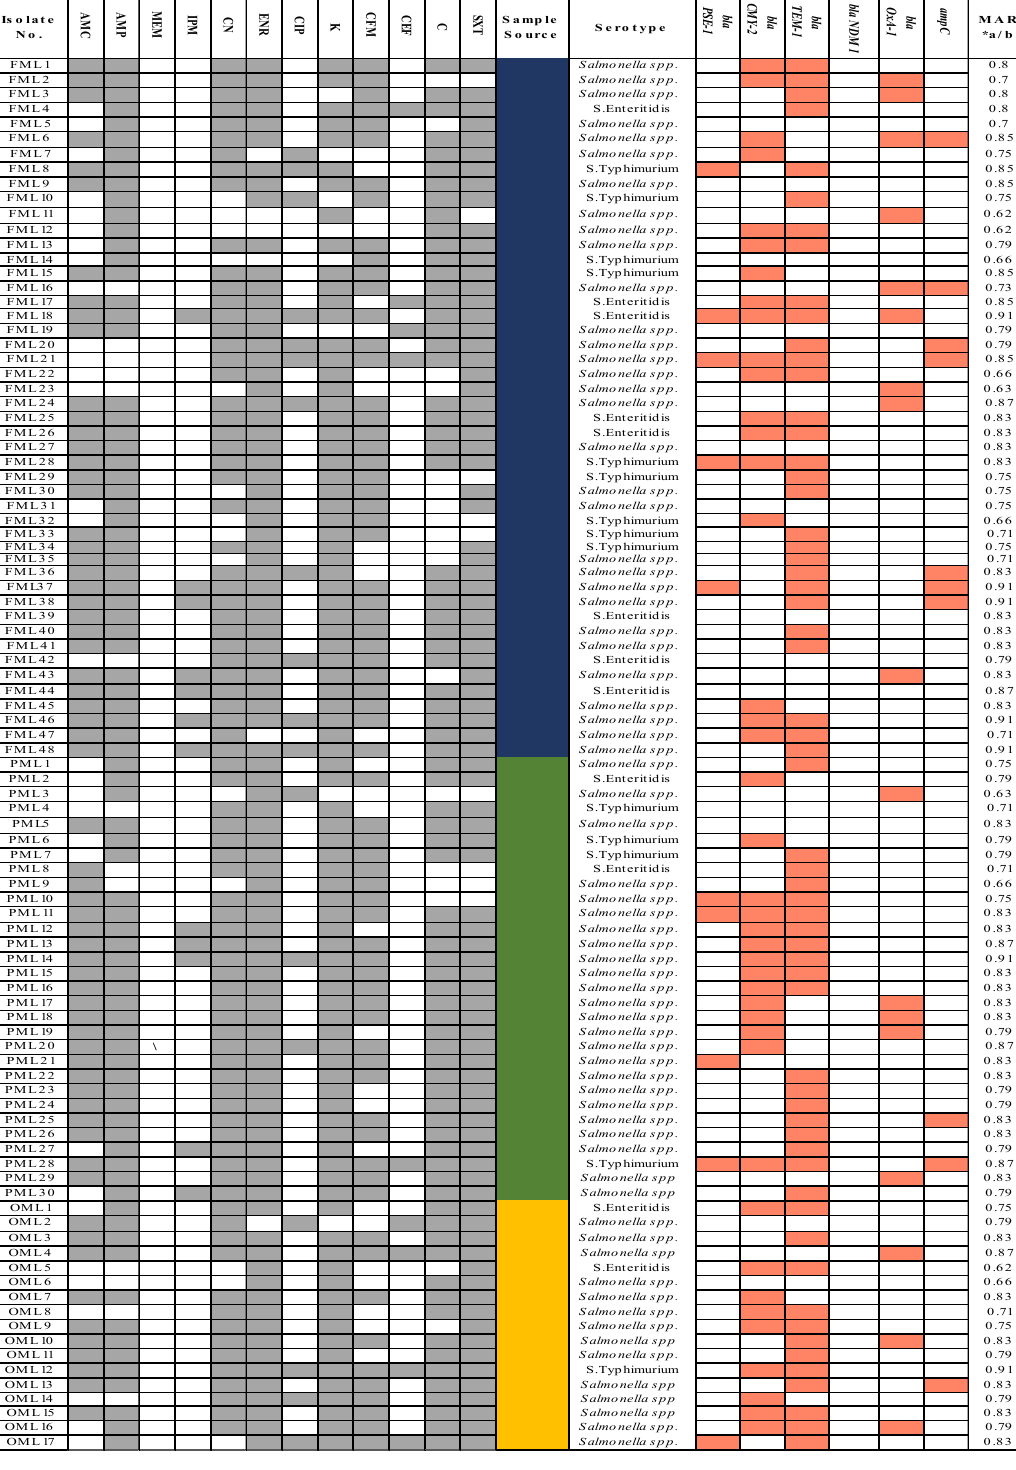
Figure 1. Salmonella strains (95) showing phenotypic antibiotic resistance profiles of 12 antibiotics, their source, origin, serotypes, and MAR index. Black squares indicate resistance; white squares indicate susceptibility; red squares indicate the presence of AMR genes; blue color presents isolates from poultry droppings, green; poultry food products (meat and eggs), yellow; poultry organs. Abbreviations: C: chloramphenicol (30 µ g); AMC: amoxicillin-clavulanic acid (10 µ g): CIP; ciprofloxacin (10 µ g); CN: gentamicin (10 µ g); SXT: sulfamethoxazole/trimethoprim (25 µ g); K: kanamycin(30 µ g): AMP: ampicillin (30 µ g); MEM: meropenem (10 µ g); IPM: imipenem (10 µ g); CEF: cefepime (30 µ g); CFM: cefixime (5 µ g); ENR: enrofloxacin (10 ug); MAR: multiple antibiotic resistance; a*: No. of antibiotics resistant; b*: No. of antibiotics